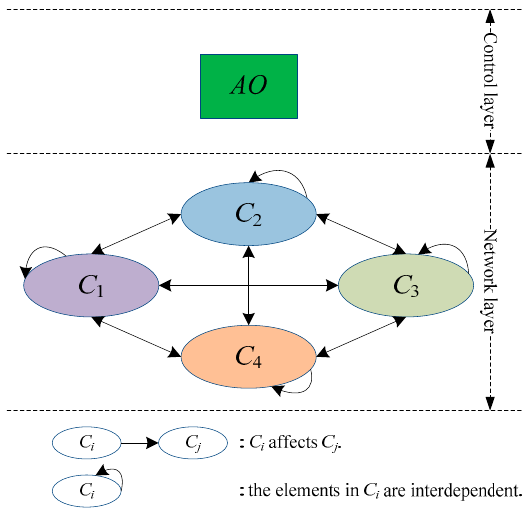
Figure 2. The ANP structure of green supplier assessment.